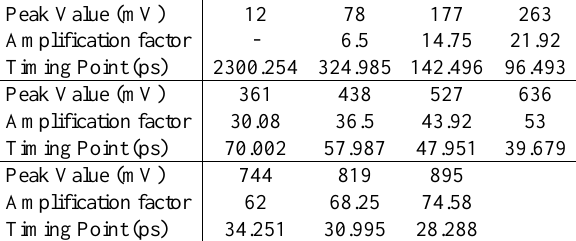
Table 1. The characteristic parameters of the received signal